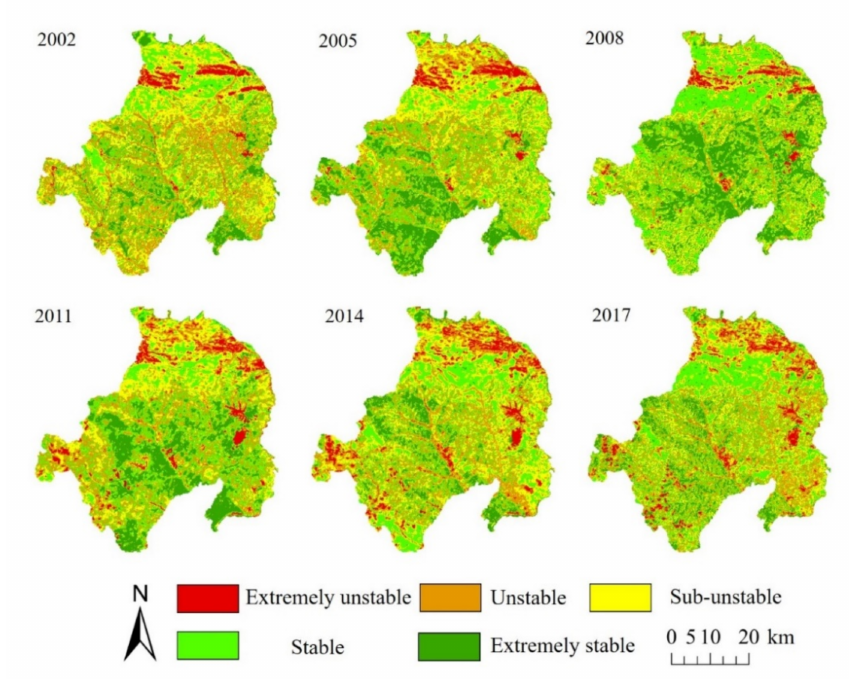
Figure 5. The spatial distributions of ecological stability from 2002 to 2017.